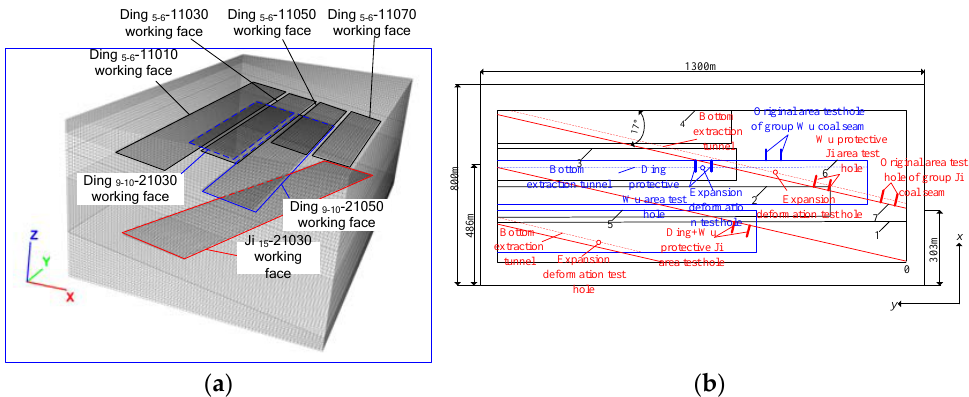
Figure 2. Spatial position relationship of working faces in the evaluation area: ( a ) working face space position; ( b ) working face plane projection. 1. Ding5-6-11010 working face; 2. Ding5-6-11030 working face; 3. Ding5-6-11050 working face; 4. Ding5-6-11070 working face; 5. Wu9-10-21030 working face; 6. Wu9-10-21050 working face; 7. Ji15-21030 working face. The black lines show the working face and measuring point located in coal seam Ding5-6, the blue lines show the working face and measuring point located in coal seam Wu9-10, and the red line shows the working face and measuring point located in coal seam Ji15.